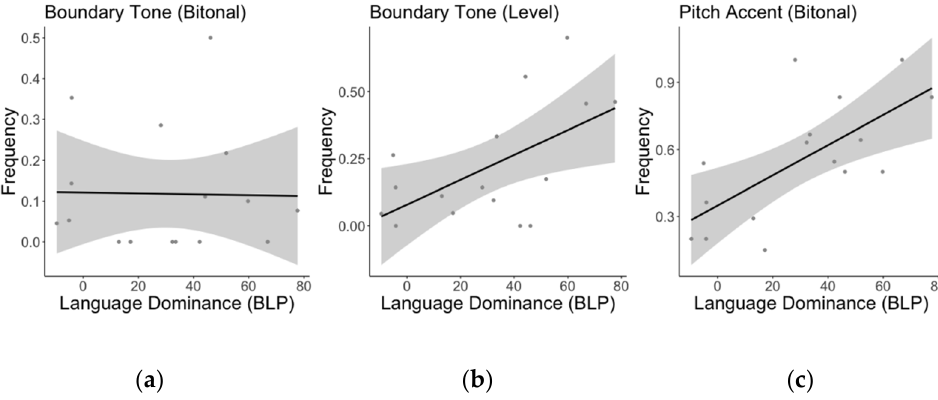
Figure 3. ( a ) Frequency of bitonal rising boundary tones by language dominance (BLP); ( b ) Frequency of level boundary tones by language dominance (BLP); ( c ) Frequency of bitonal pitch accents (with non-bitonal rising boundary tones) by language dominance (BLP).